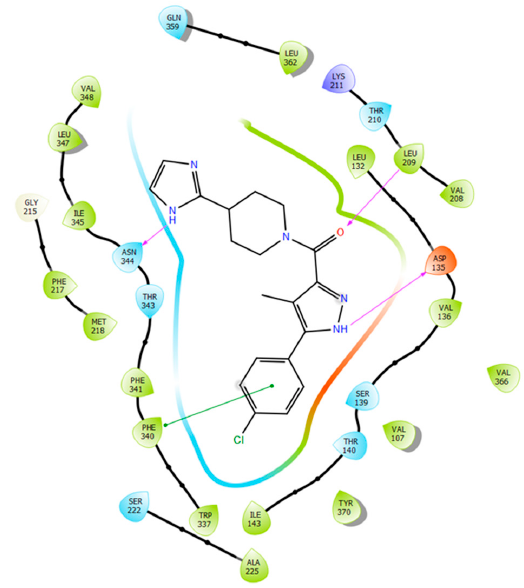
Figure 6. Structure of hit compound ( 8 ) and its closest literature analogue ( 17 ).